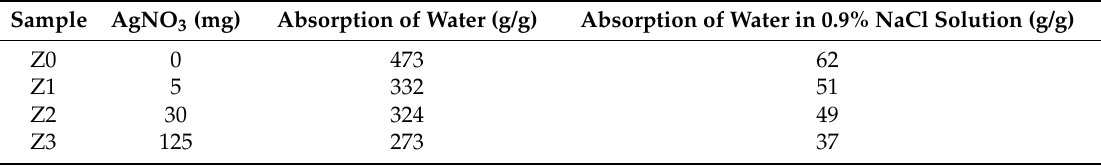
Table 2. The effects of AgNO 3 amounts on the swelling ratio of the samples.